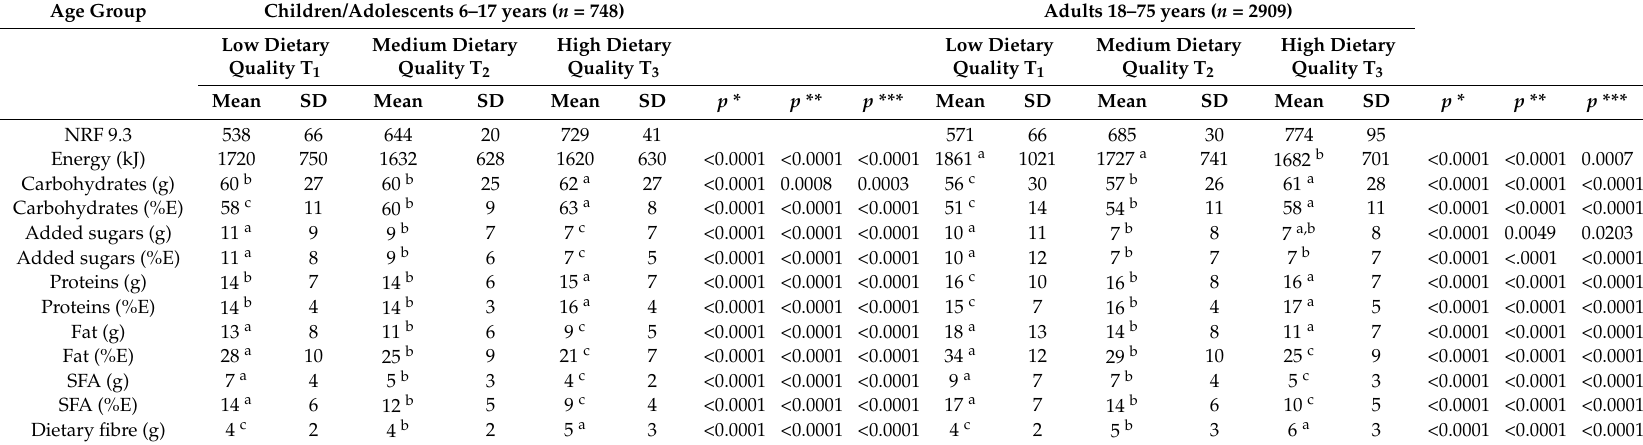
Table 4. The mean intake at breakfast of energy and micronutrients among breakfast consumers across the tertiles of the NRF 9.3 score according to age in